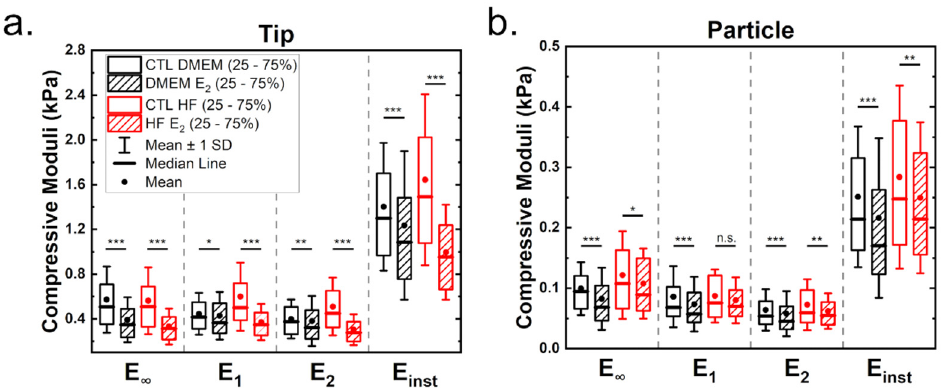
Figure 3. Viscoelastic mechanical properties determined from stress relaxation curves for measurements employing tips ( a ) and particles ( b ). The stress relaxation segment was recorded at a load of 2 nN (corresponding to an indentation of approximately either 2 or 1.25 µm, respectively) and a duration of 10 s. Statistical significances are reported as * for p < 0.05, ** < 0.01 and *** < 0.001. Table 1. Median values of the elastic and viscoelastic properties derived for measurements on MCF-7 cells with either tips or particles (CTL and estrogen-treated).